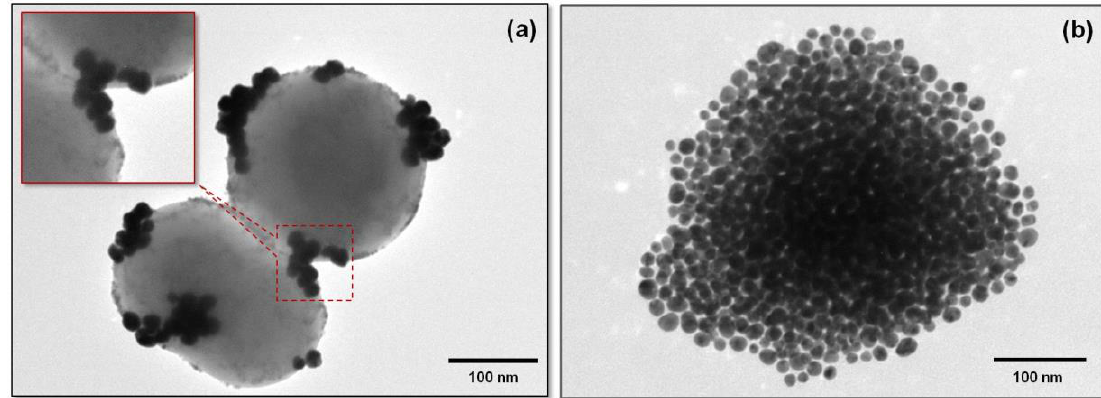
Figure 8. TEM image of incomplete decorated magneto-liposomes (MLP50). The inset highlights the presence of PEGylated AuNPs on the outer surface of the liposomes and of SPIONs inside the lipidic bilayer ( a ). TEM image of a single plasmonic magneto-liposome (MLP50) ( b ).